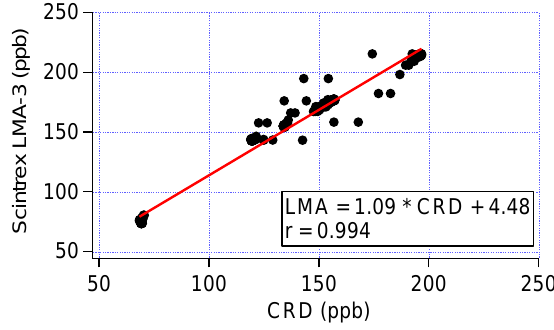
Fig. 2. Comparison between the Scintrex LMA-3 detector and the Cavity Ring-down Spectrometer during an NO 2 calibration of the PERCA instrument.